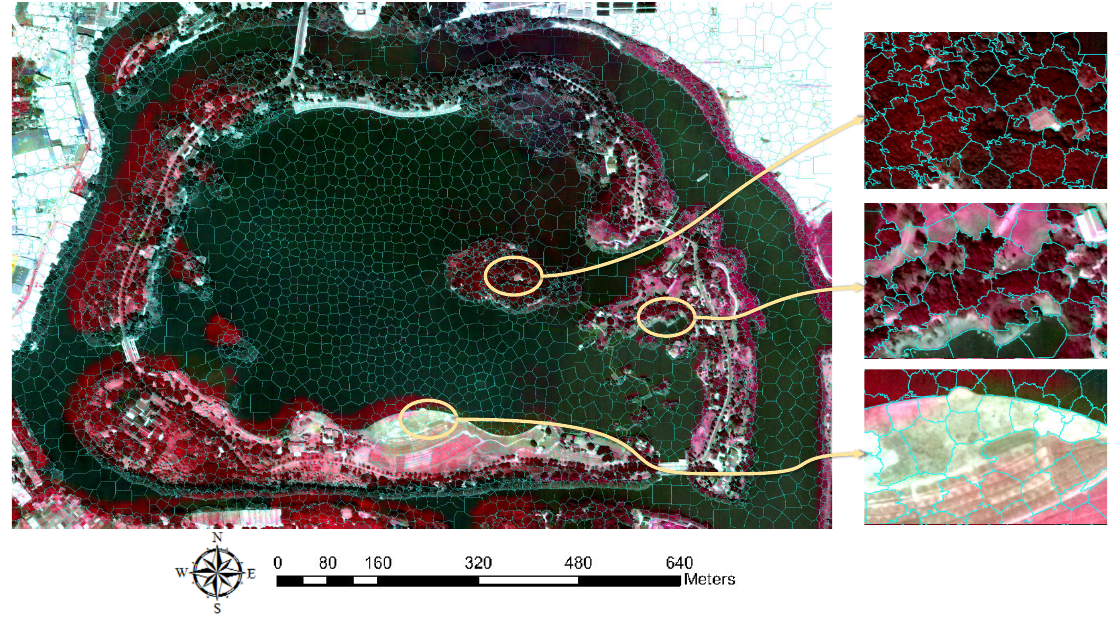
Figure 8. Superpixel segmentation result.